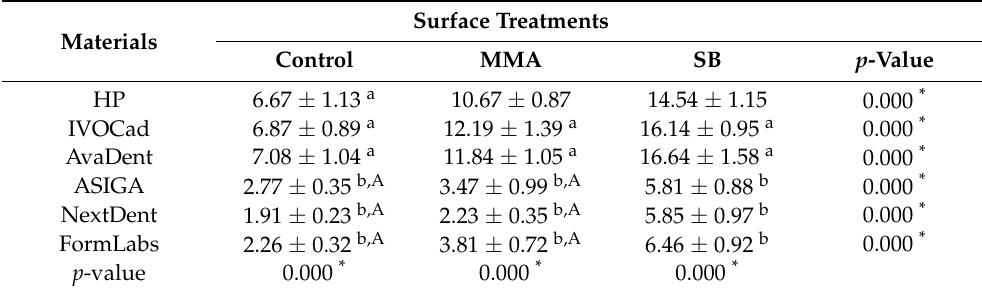
Table 2. Mean values, SD, and significance in SBS (MPa) of the experiment groups.